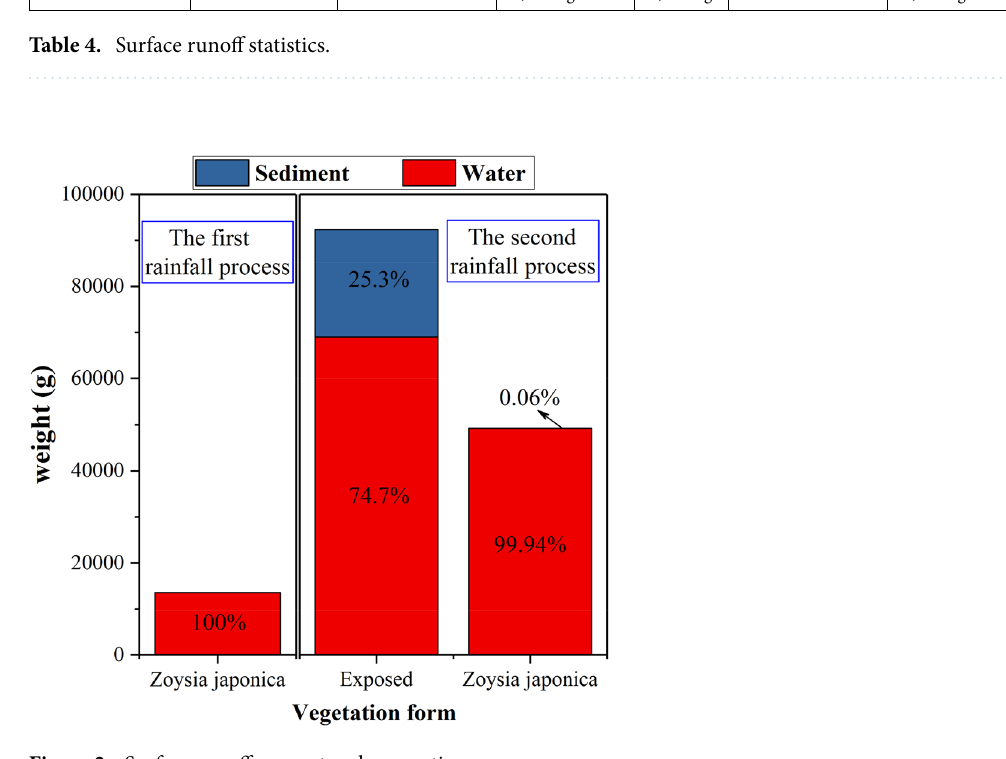
Figure 2. Surface runoff amount and